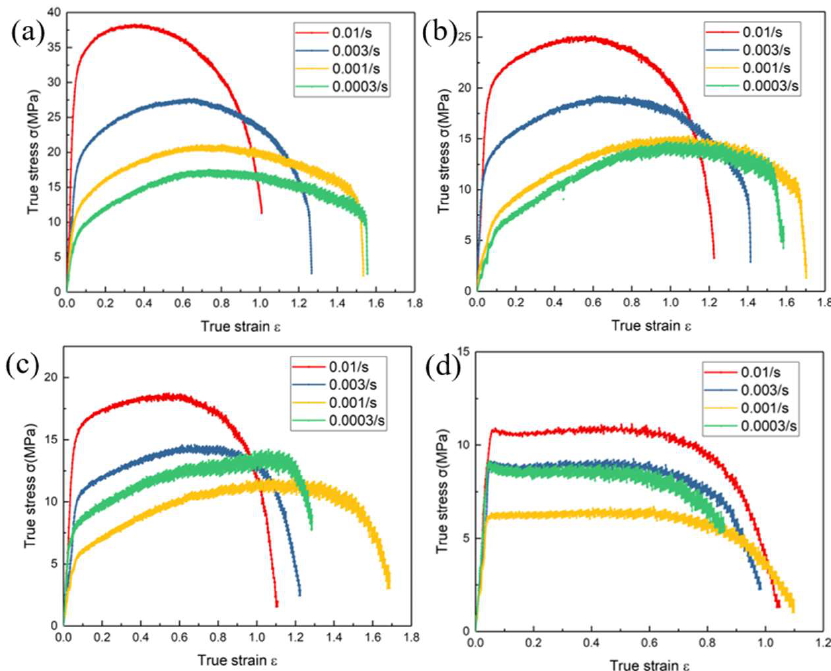
Figure 6. Stress–strain curves of FSW samples obtained at different deformation parameters: ( a ) 400 °C; ( b ) 450 °C; ( c ) 500 °C; ( d ) 550 °C.